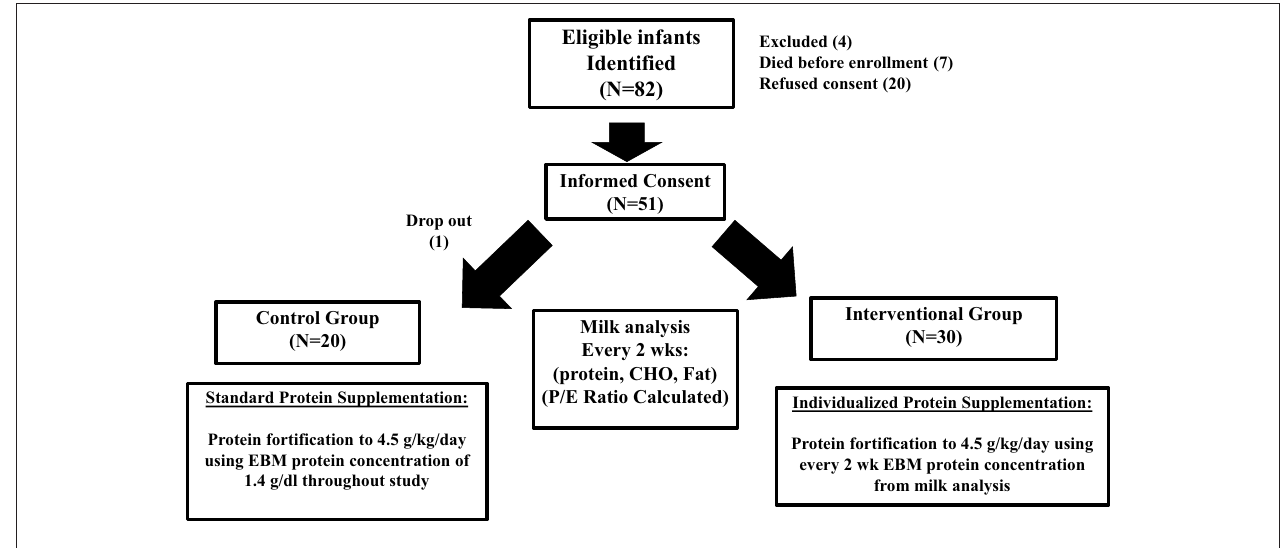
FIGURE 1 | Flow chart showing the study population.